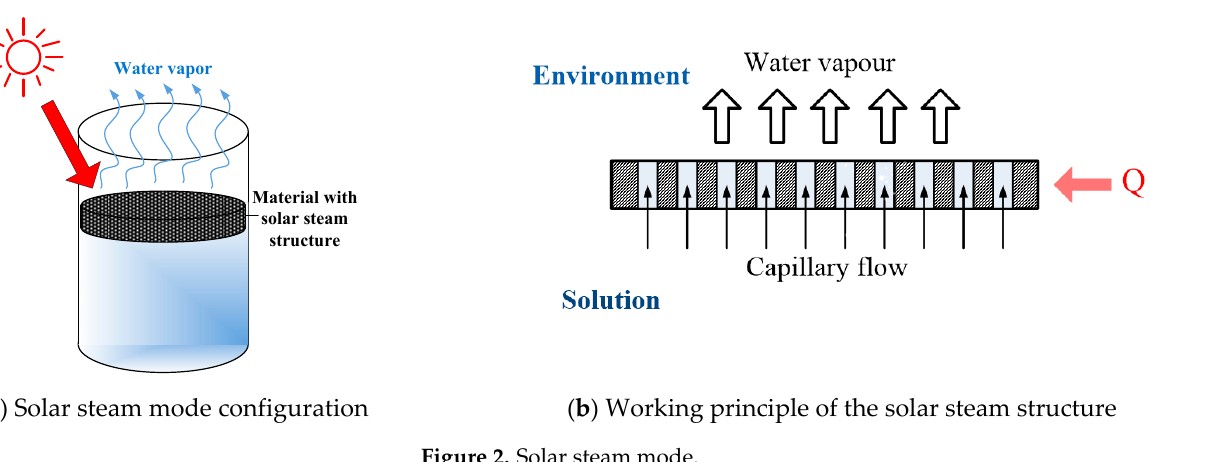
Figure 2. Solar steam mode.